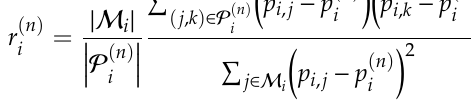
Figure 2. Snapshots (circles) are colored in the bottom row of each sub-figure by descendant group G where for ( a ) n = 0 ( b ) n = 1, ( c ) n = 2, ( d ) n = 3. Each row represents a level, and each circle corresponds to an observed snapshot at the level. The common n th-order ancestor snapshot of each group is also colored, and the lineage paths are colored as well. Parts ( b – d ) show the 1st, 2nd, and 3rd-order descendant groups,